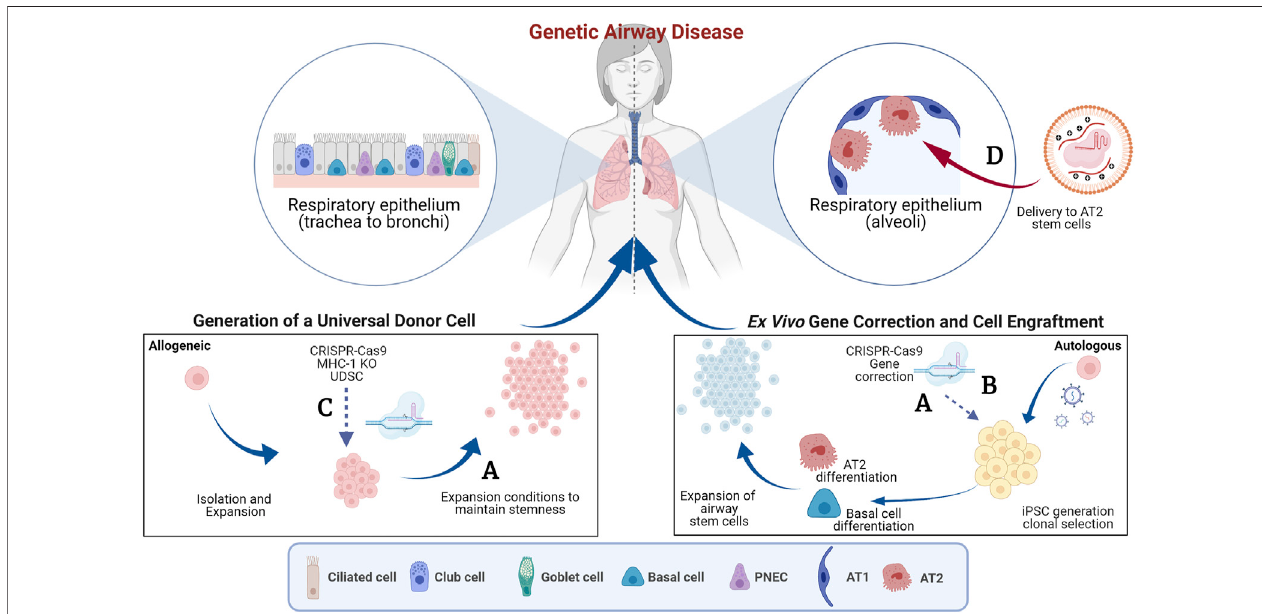
FIGURE 1 | Genome editing to target the airway epithelium. This schematic summarizes the concepts features in the Research Topic. The blue arrows indicate pathways of ex vivo manipulation and subsequent delivery to the lung and the red arrows indicate direct delivery. (A) Generation of autologous gene-corrected airway basal cells (BCs) and expansion of primary BCs ex vivo (Barilla et al.). (B) Use of a double nicking CRISPR-Cas9n and intrachromosomal homologous recombination to overcome vector genome insertion events (Suzuki et al.). (C) Generation of beta-2 micro-globulin (B2M) knock-out (KO) cells to reduce immune rejection of cell therapies (Kararoudi et al.). (D) Delivery of gene editing tools to the distal airways using viral and non-viral approaches (Cooney et al.). AT1, Alveolar type 1 epithelial cell; AT2,Alveolartype2epithelialcell;iPSC,inducedpluripotentstemcell;MHC-1,Majorhistocompatibilitycomplex1;PNES,pulmonaryneuroendocrinecells.Createdwith